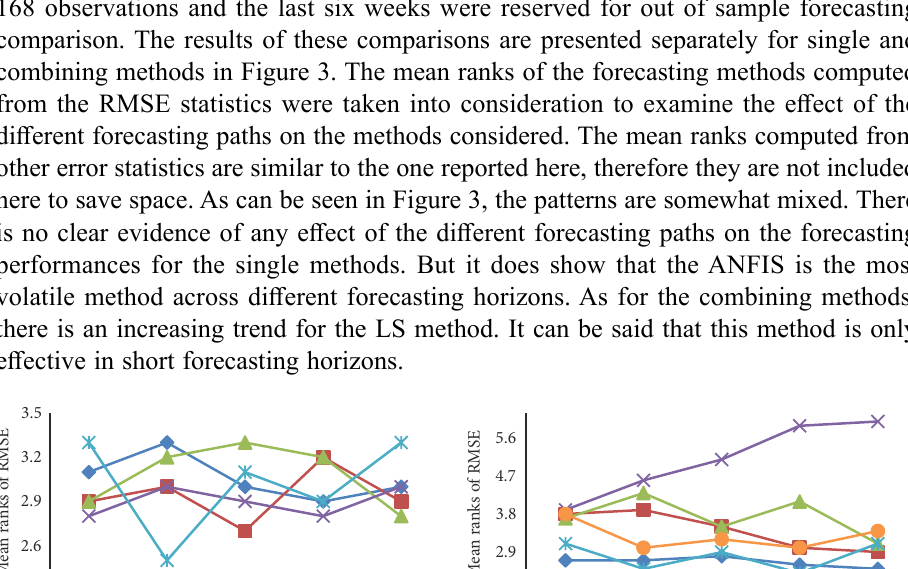
Table 4. Forecasting results of the single models and combining methods for Data 1 and 2